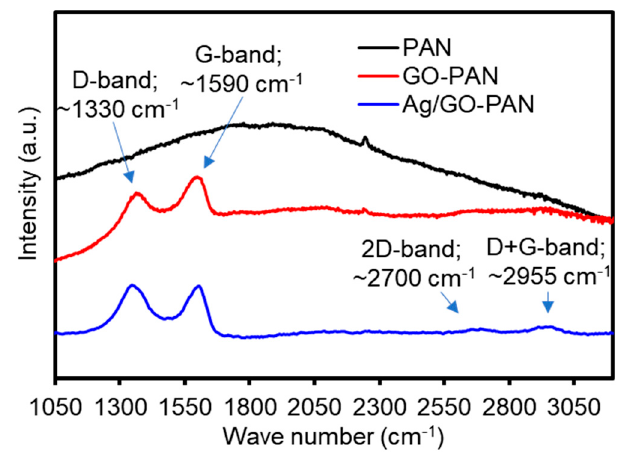
Figure 3. Raman spectra of nanofiber membranes.